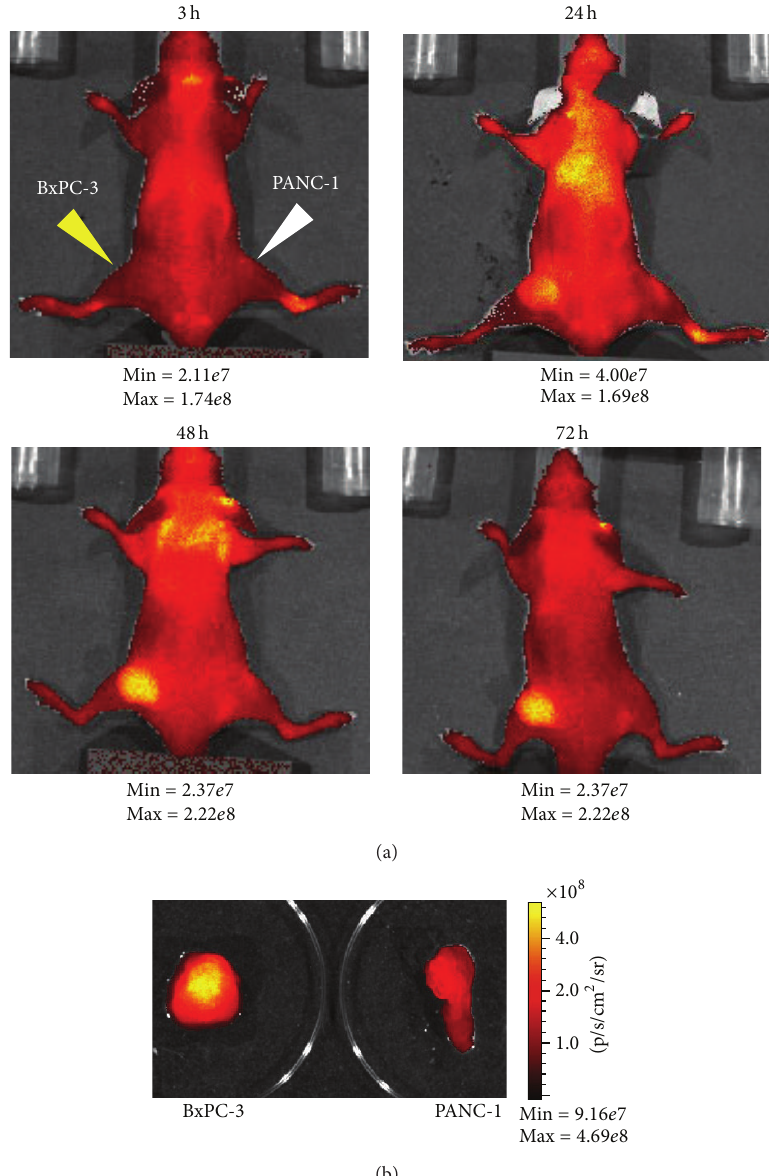
Figure 3: In vivo and ex vivo NIR optical imaging by Alexa Fluor 750-labeled 11-25 mAb. (a) Alexa Fluor 750-labeled 11-25 mAb (90 𝜇 g/mouse) was administered to mice bearing BxPC-3 and PANC-1 intravenously. Alexa Fluor 750 fluorescence was then monitored by IVIS-200 imaging system 24, 48, and 72 hours after the injection. The minimum and maximum values of the photon gage are shown under each photograph. (b) 24 hours after administration of Alexa Fluor 750-labeled 11-25 mAb, tumors were dissected from mice and ex vivo fluorescence images were